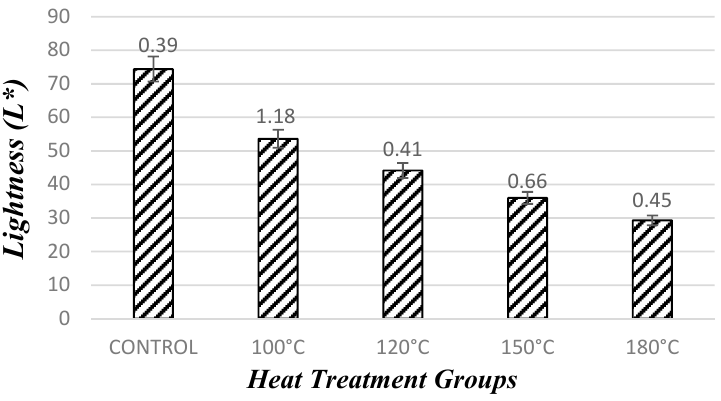
Figure 11. Color values of the samples after densification process.